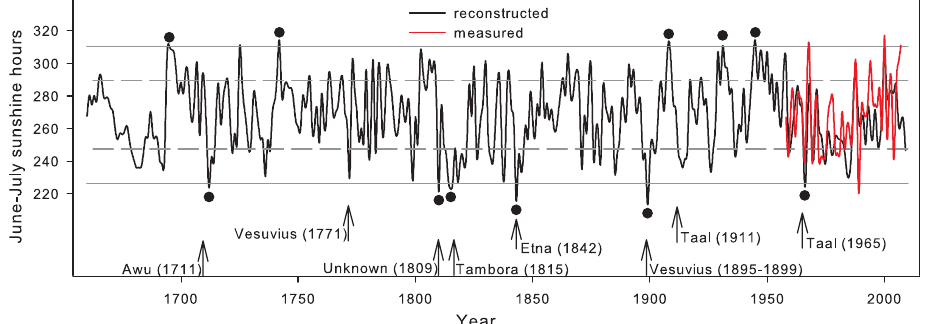
Fig. 5. Reconstructed (black line) and measured (shorter red line) mean June–July sunshine hours. Solid grey lines delineate two, while dashed grey lines represent one standard deviation from the mean, calculated over the reconstructed period 1660–2010. Black dots mark identified extreme summers and arrows indicate larger volcano eruptions; Awu (Clor et al., 2005), Vesuvius (Scandone et al., 2008), unknown and Tambora (Cole-Dai et al., 2009), Etna (Bonaccorso et al., 2004) and Taal (Mastin and Witter,